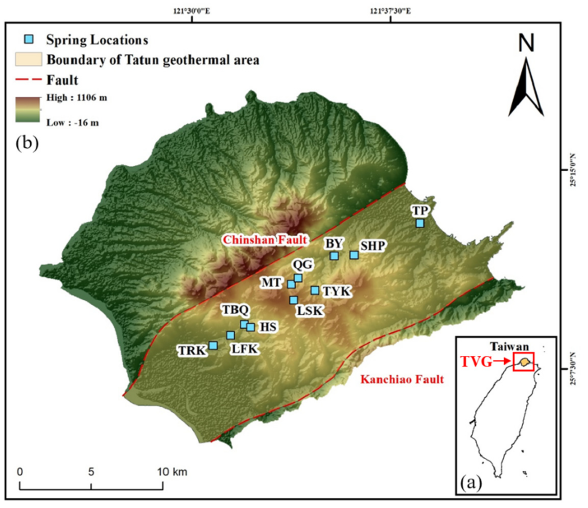
Figure 1. ( a ) Inset map of Taiwan showing the location of Tatun Volcano Group (TVG); ( b ) a map of TVG highlighting geothermal areas (springs, fumaroles).